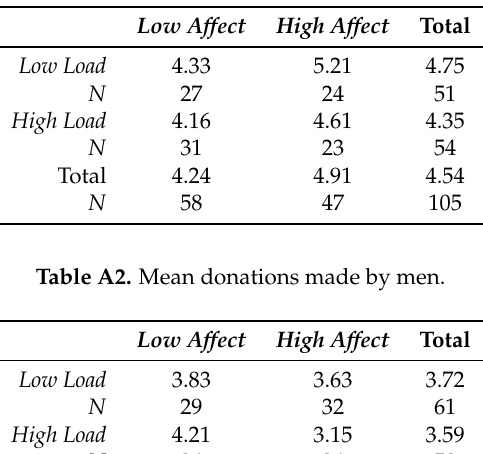
Table A1. Mean donations made by women.